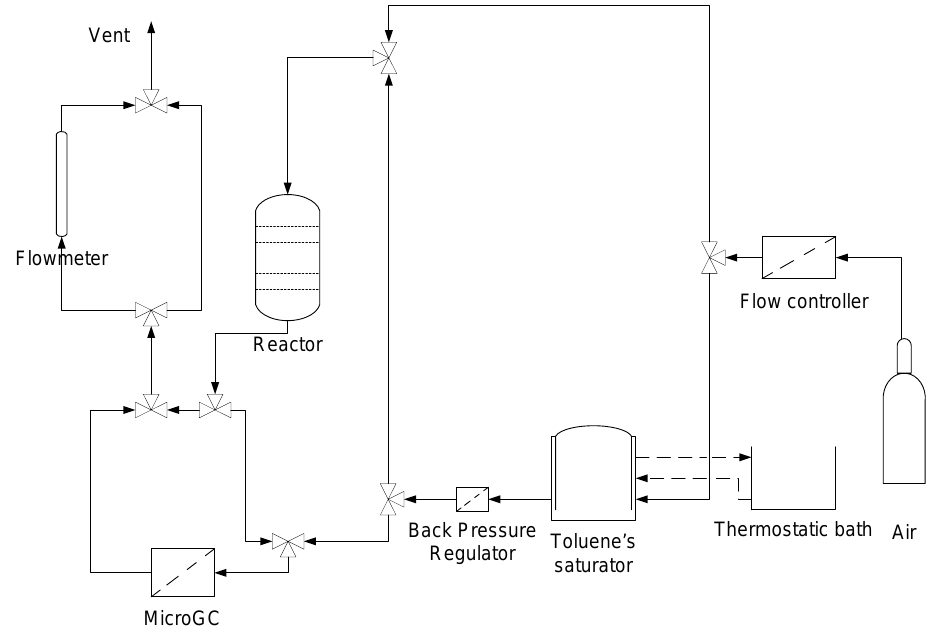
Figure 10. Toluene adsorption and catalytic